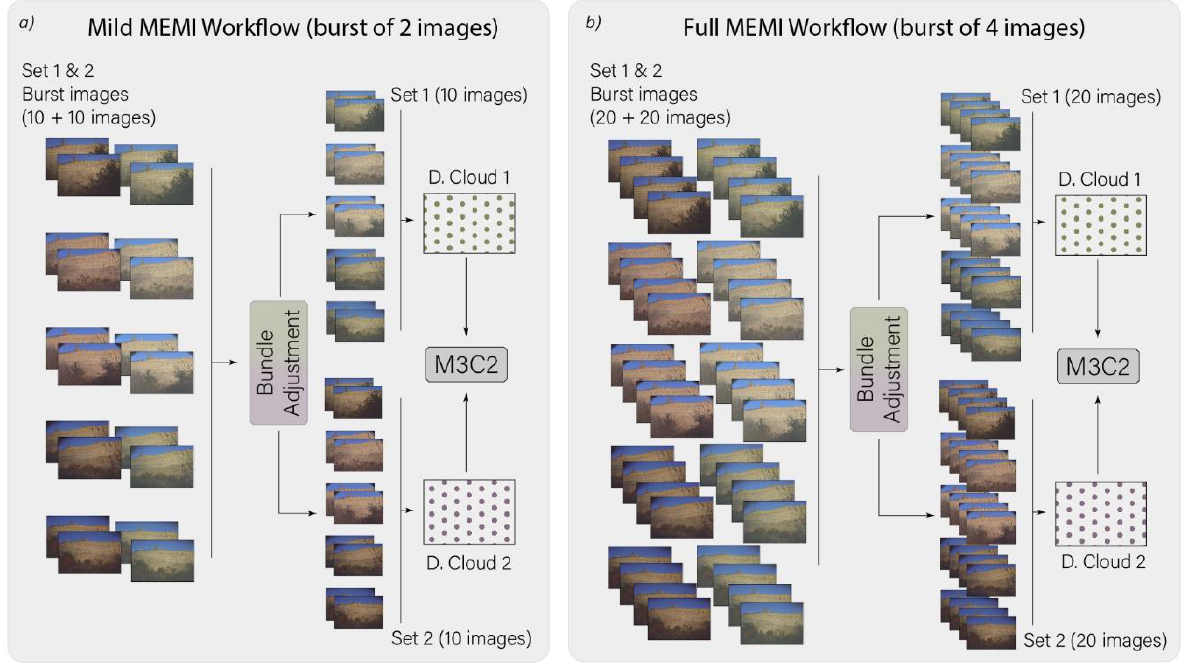
Figure 5. ( a ) Mild MEMI workflow created for the change detection evaluation. ( b ) Full MEMI workflow created using all images available.